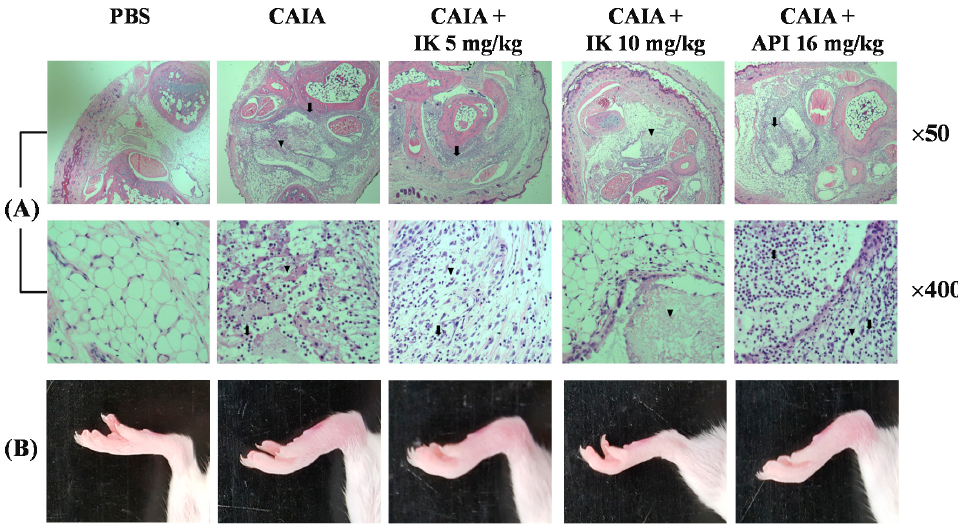
Figure 1. Image of representative microscopic features of knee joint ( A ) and mice joint ( B ). Isoegomaketone (IK) and apigenin (API) were administered via oral gavage once per day for 4 days. Arrow indicates infiltration of neutrophils and arrowhead indicates the necrosis.